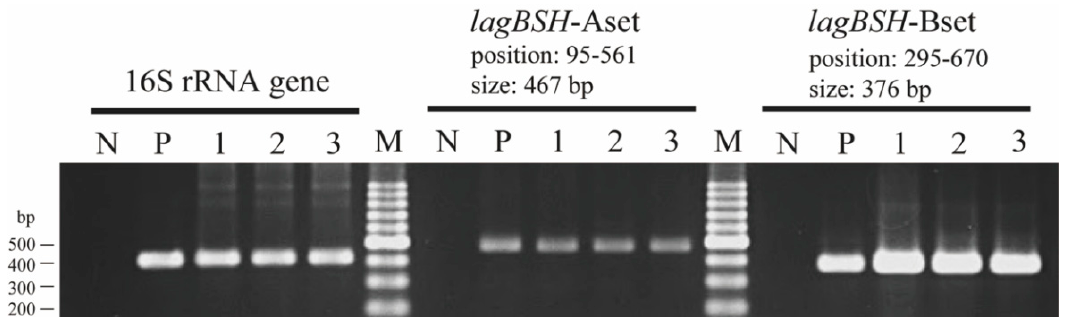
Figure 6. RT-PCR analyses of lagBSH genes in L. gasseri JCM1131 T . Sterilized water (lane N) and genomic DNA of strain JCM1131 T (lane P) were used as negative and positive control, respectively. The products of reverse transcription from total RNA of nonsupplemented (lane 1), TCA-supplemented (lane 2), and TDCA-supplemented (lane 3) strain JCM1131 T cells were used as the template for PCR, respectively. The 16S rRNA gene (378 bp) was used as internal standard control. Lane M, molecular size markers (100 bp DNA ladder, Promega, Madison, WI, USA).